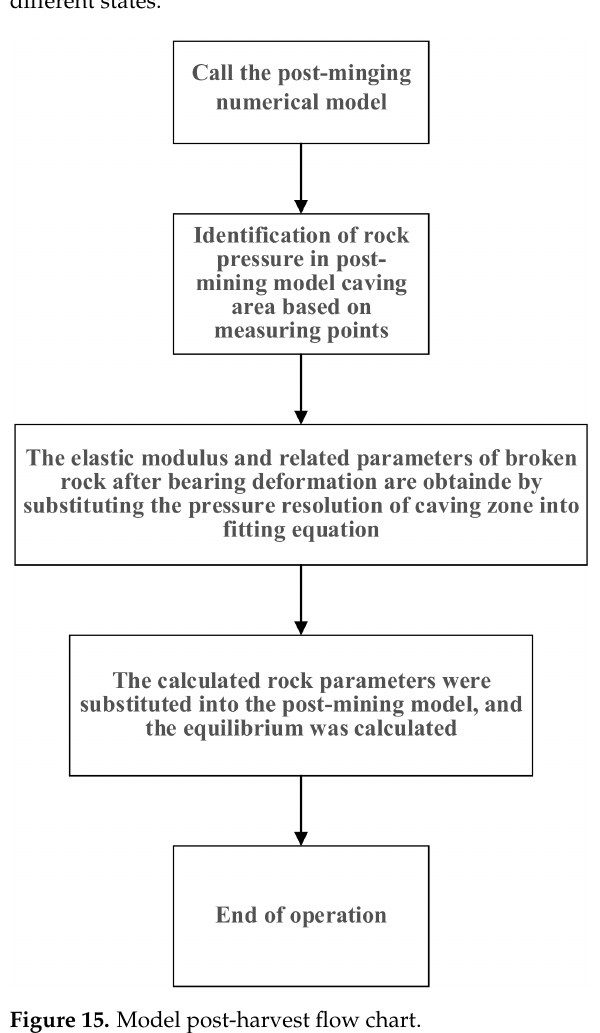
Figure 15. Model post-harvest flow